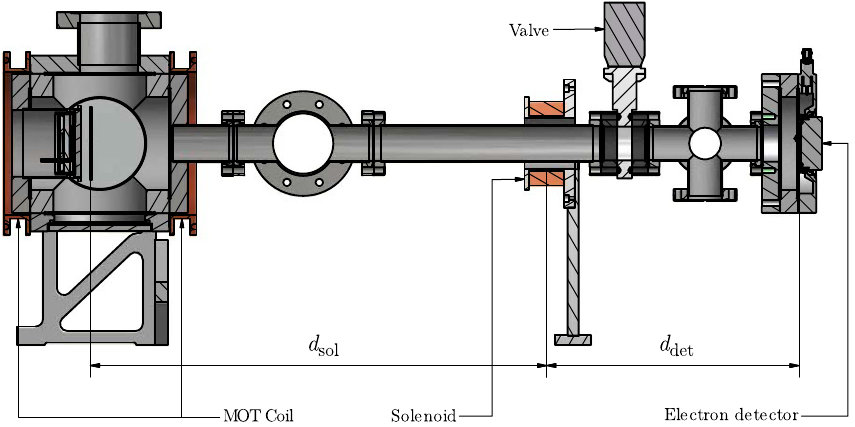
FIG. 7. Final kinetic energy U (black) and the simulated electric field E z (red) as a function of distance D the grating.